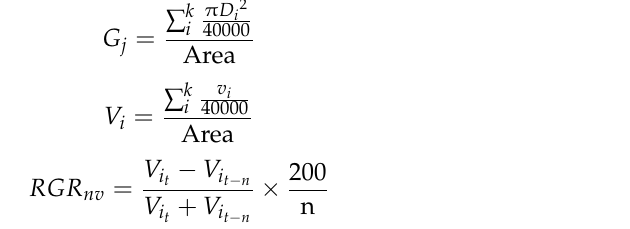
where V i and V i represent the initial and final stand volume of i th plot, respectively, t − n t which are equivalent to the accumulation of the live stand volume, ingrowth volume, and harvest volume; k represents the numbers of plot; n represents the investigation interval in Equation